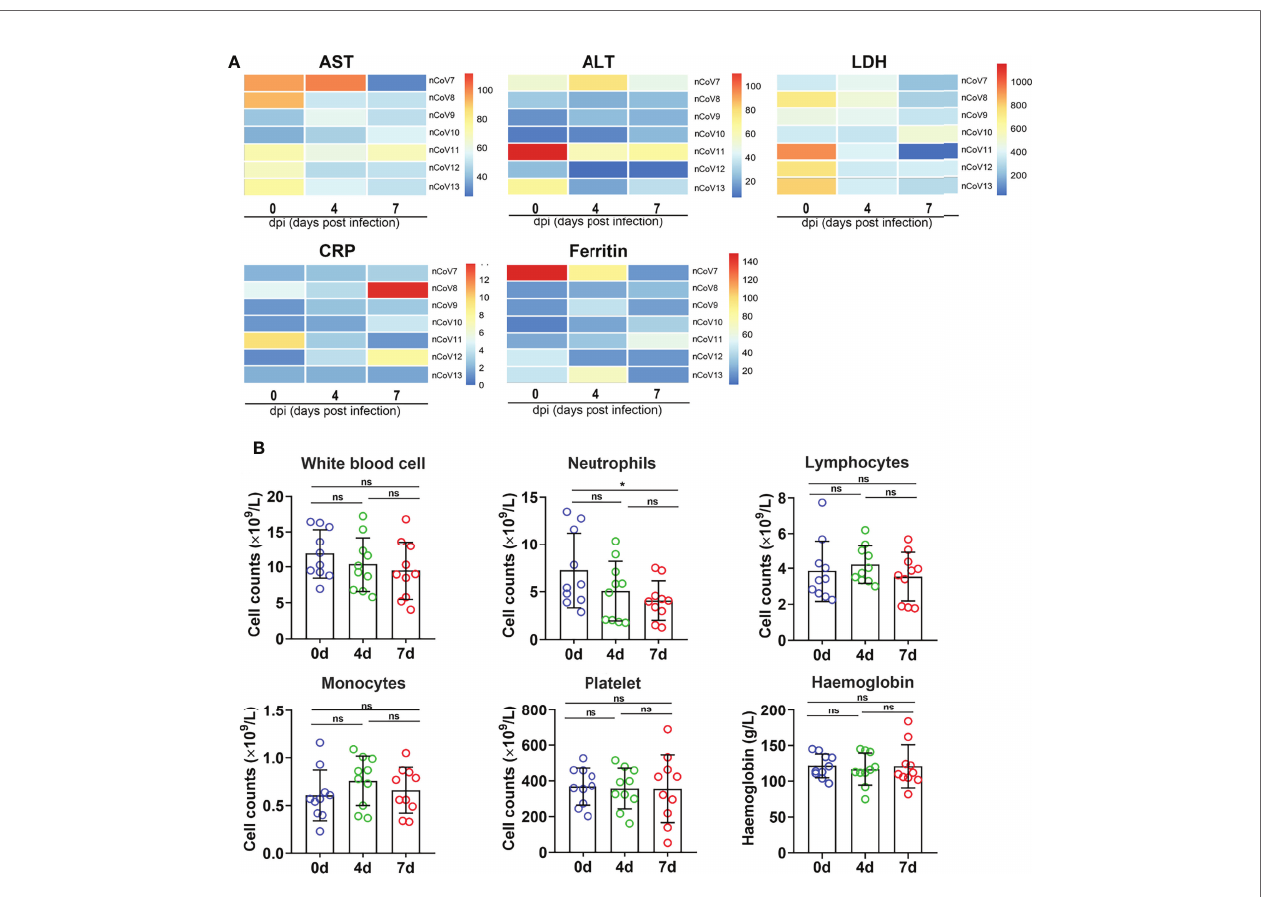
FIGURE 3 | Clinical features in monkeys inoculated with SARS-CoV-2. (A) The infection indicators (AST, ALT, LDH, CRP and Ferritin) were examined at indicated time points and compared with each other. The 0 dpi (before infection) of each monkey was put as the control of itself. The heatmap was prepared via heatmap illustrator in TB tools. (B) The counts and proportion of indicator cells in PBMC were detected at indicated time points in macaques before and after SARS-CoV-2 challenge, and the analysis was plotted in GraphPad Prism 8.0.1. *p<0.05. ns, not signi fi cant. AST, aspartate transaminase; ALT, alanine transaminase; LDH, lactate dehydrogenase; CRP, C-reactive protein; nCoV, SARS-CoV-2; PBMC, peripheral blood mononuclear